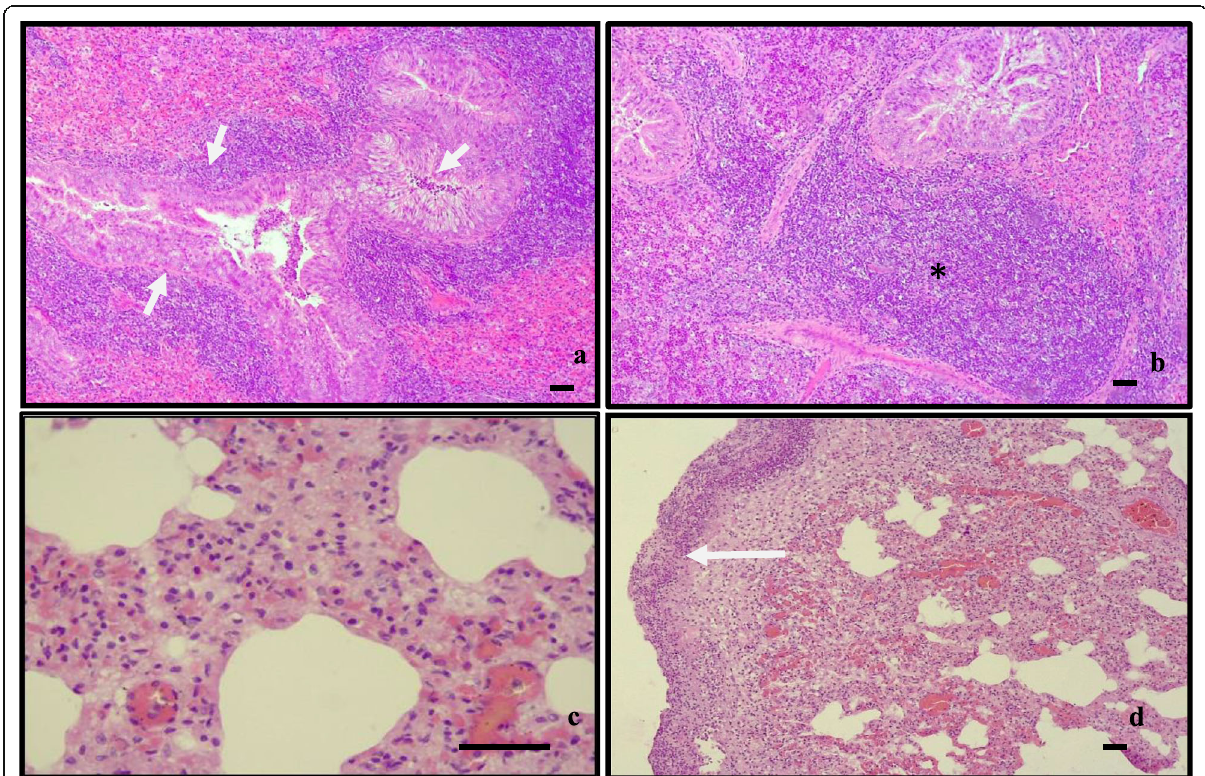
Fig. 5 Histological changes in the lungs. a Marked hyperplasia of the bronchi epithelium with a bronchi lumen containing an exudate (white arrows), Bar means 100 μ m b Marked peribronchial and perivascular lymphoid nodules (black star) with alveolitis, Bar means 100 μ m c Thickening of the alveoli due to mononuclear lymphocyte infiltration and blood vessel congestion, bar 50µm d Pleurisy (white arrows). Bar means 100 μ